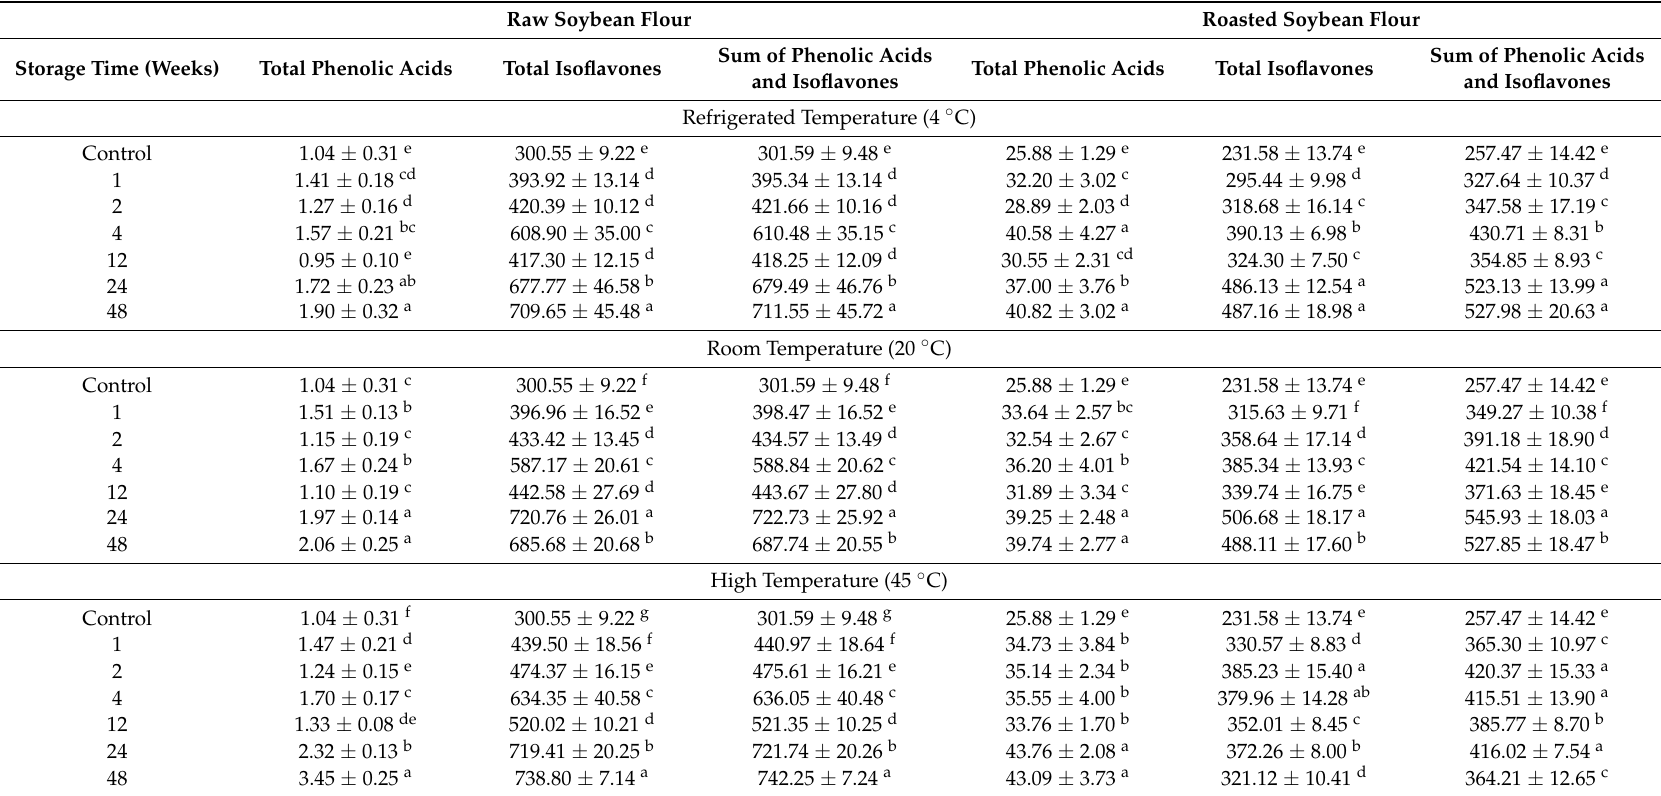
Table 3. Total phenolic acids and isoflavones in RWSF and RSF at different storage time and temperature. Raw Soybean Flour Roasted Soybean